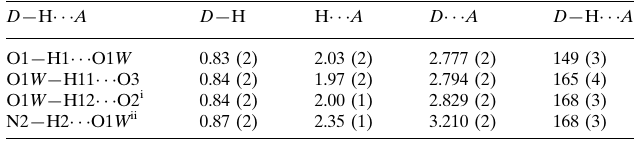
Hydrogen-bond geometry (A˚ , (cid:2)